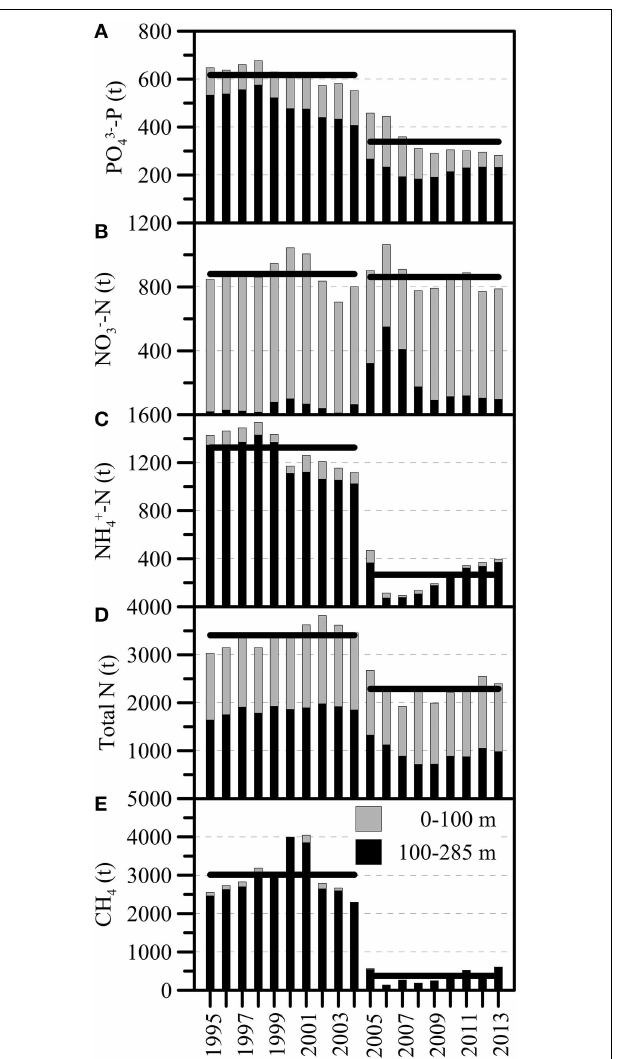
FIGURE 7 | Annual average inventories (in metric tons) for (A) PO 3 − 4 -P, (B) NO − 3 -N, (C) NH + 4 -N, (D) total dissolved fixed N, and (E) CH 4 between 1995 and 2013 (light: 0–100m and dark: 100–284 m; 100m marks the long-term average (pre-holomixis) water depth of the chemocline/redoxcline). The first of two distinct whole-water-column mixing events occurred in March 2005. Horizontal bars indicate the multi-annual means for the pre- and post-mixing periods, 1997–2004 and 2005–2013,